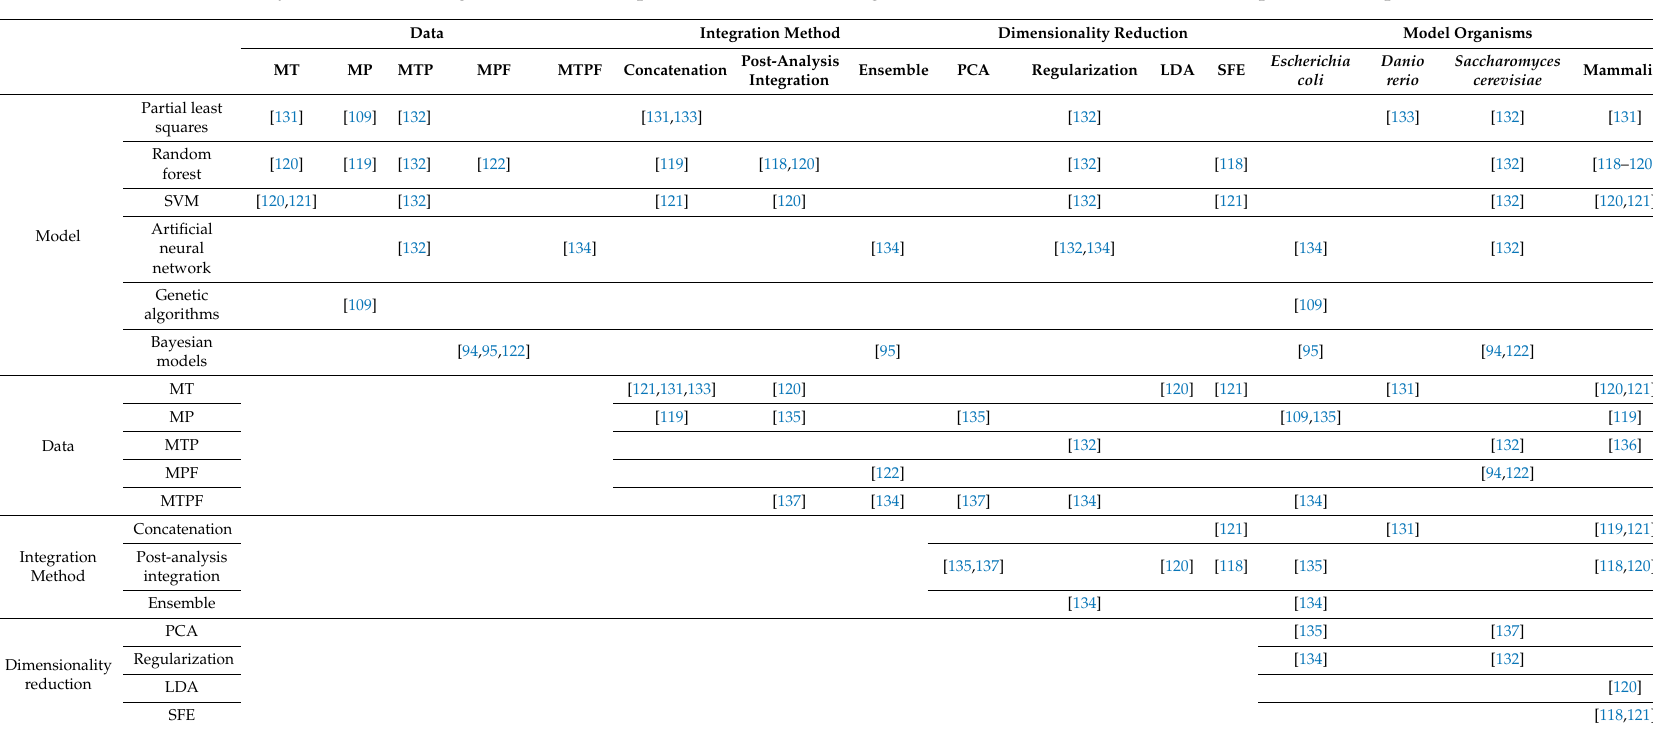
Table 6. Cross-consistency matrix with categorical research topics of multi-omics integration. M—metabolomics; T—transcriptomics; P—proteomics;